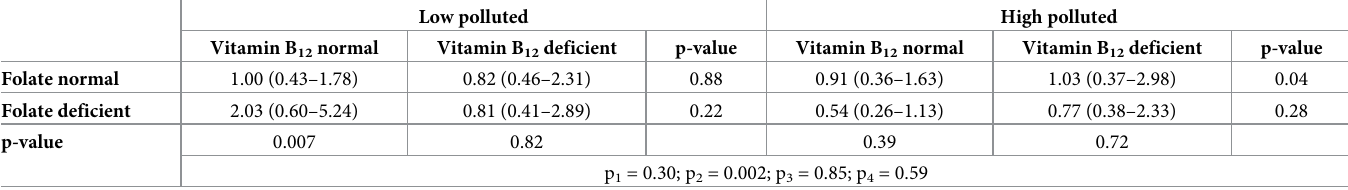
Table 2. Distribution of median (IQR) values of global DNA methylation levels with respect to micronutrient deficiency in low and high polluted areas.